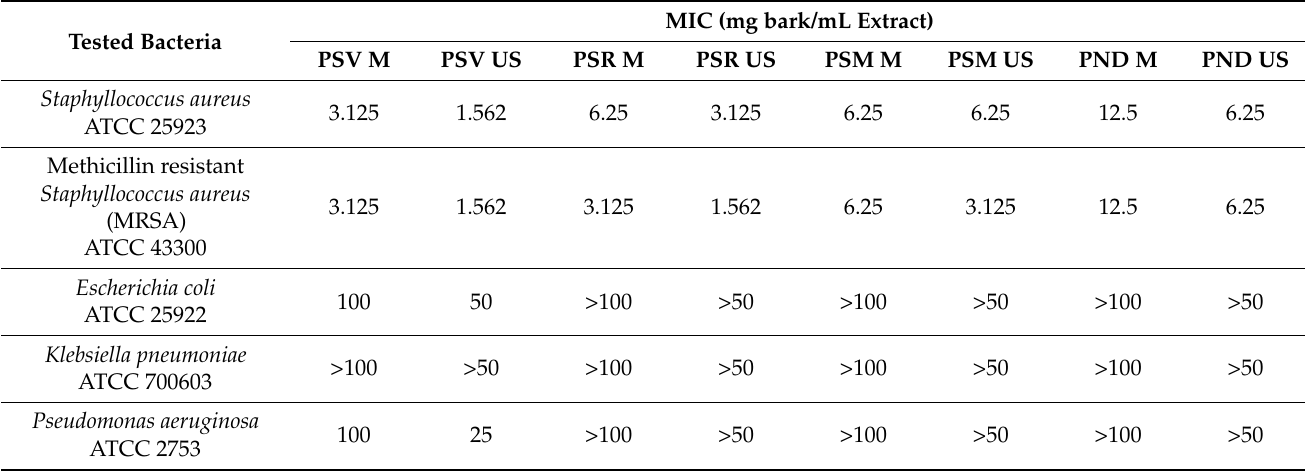
Table 3. Minimum inhibitory concentration (MIC) of the tested extracts against the bacterial strains, expressed as mg vegetal material/mL extract. Tested